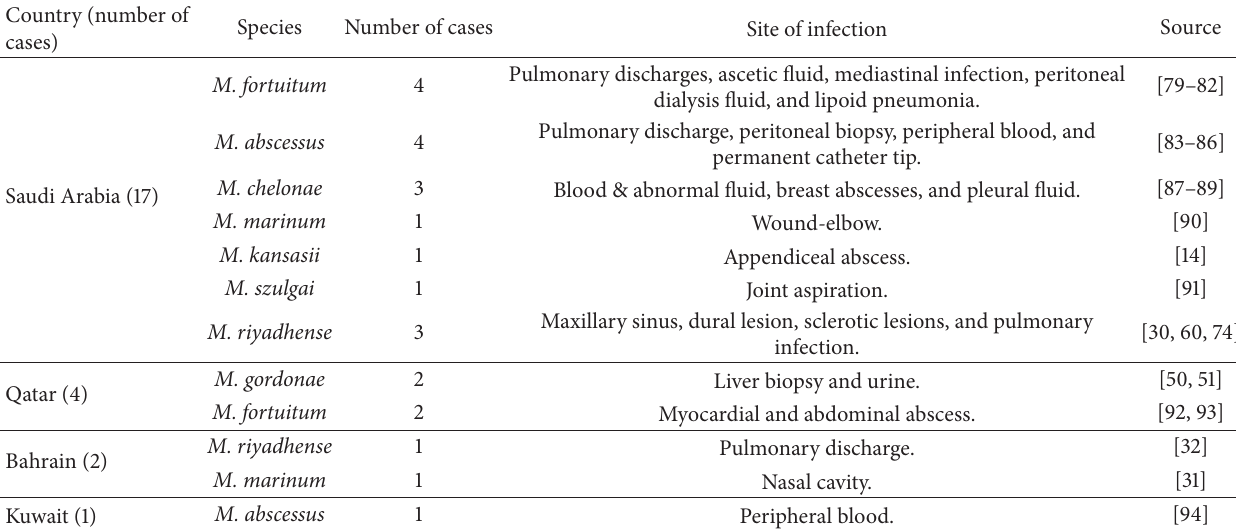
Table 2: Case studies reported from the GCC